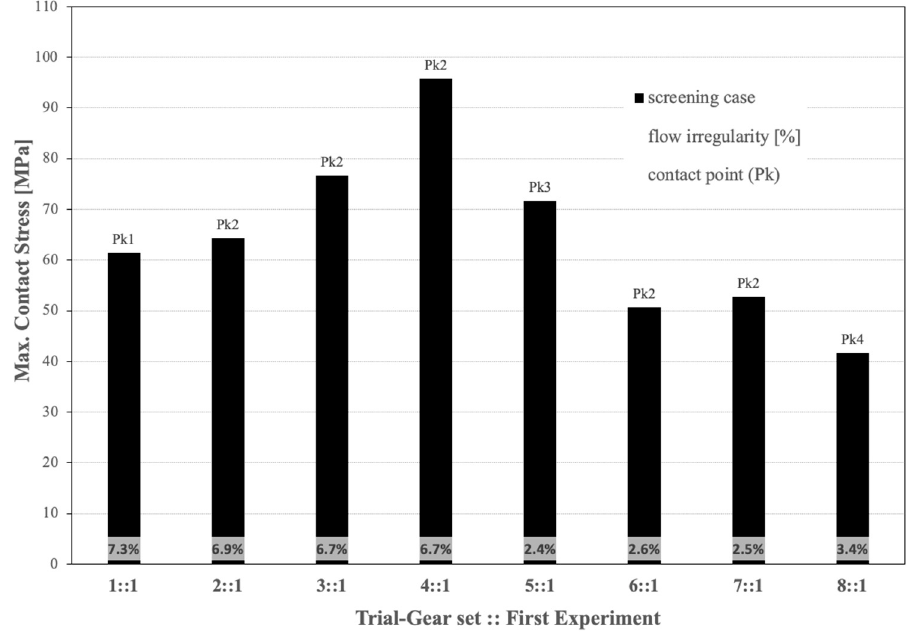
Figure 7. Results of FEM maximum contact stress [MPa], GeroLAB flow irregularity [%], and contact point (Pk) of maximum contact stress in each gear set for the first Taguchi experiment (see Table 4).